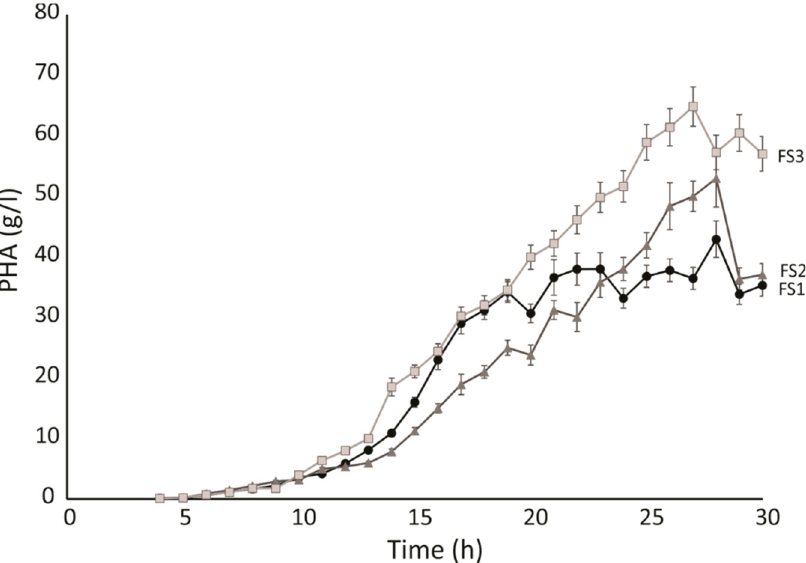
Figure 4. The dynamics of PHA (g/l) accumulation by P. putida KT2440 resulting from feed strategies FS1, FS2, and FS3. The error bars represent standard deviation among three independent biological replicates.